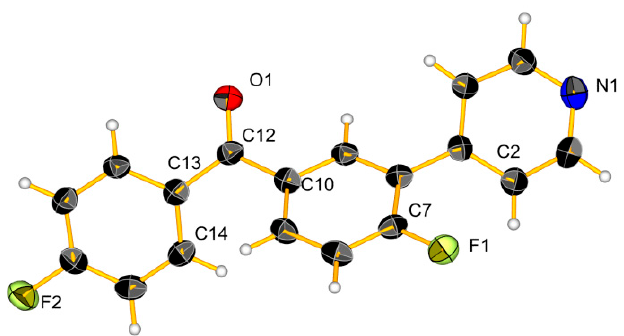
Figure 2. View of the molecular structure of 3 in ellipsoid 50% probability.